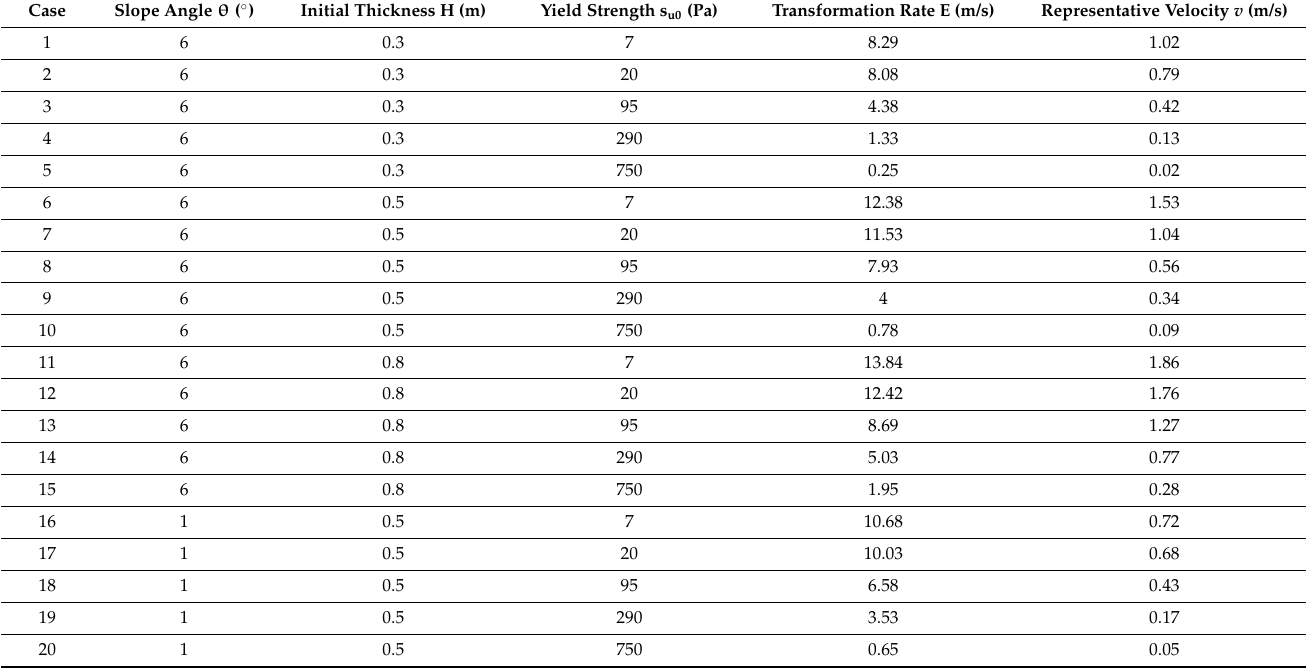
Table 1. Transformation rates for different cases at initial